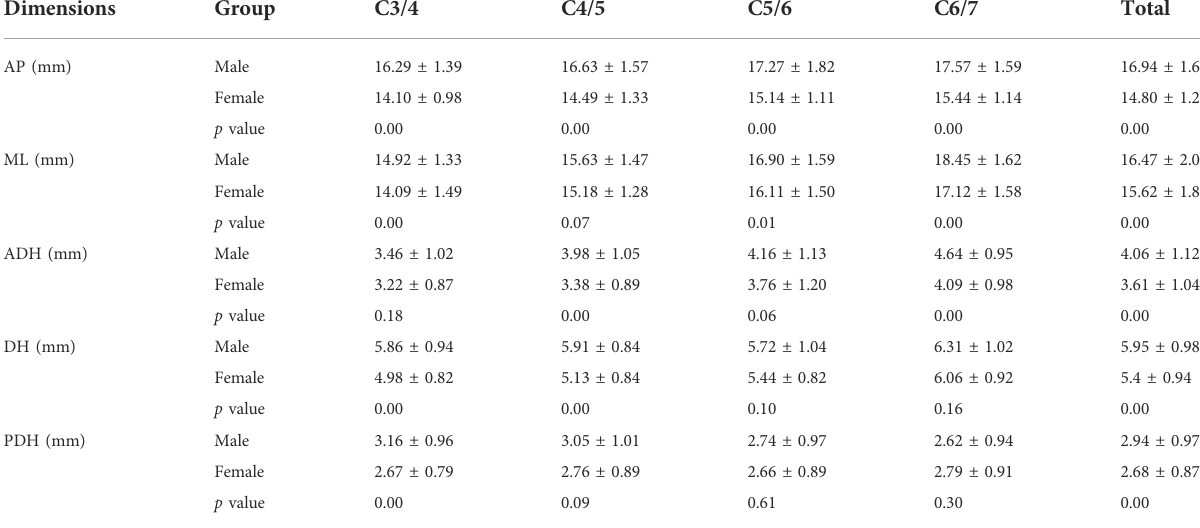
TABLE 3 Sex differences in Linear Parameters ( ‾ X ± S).